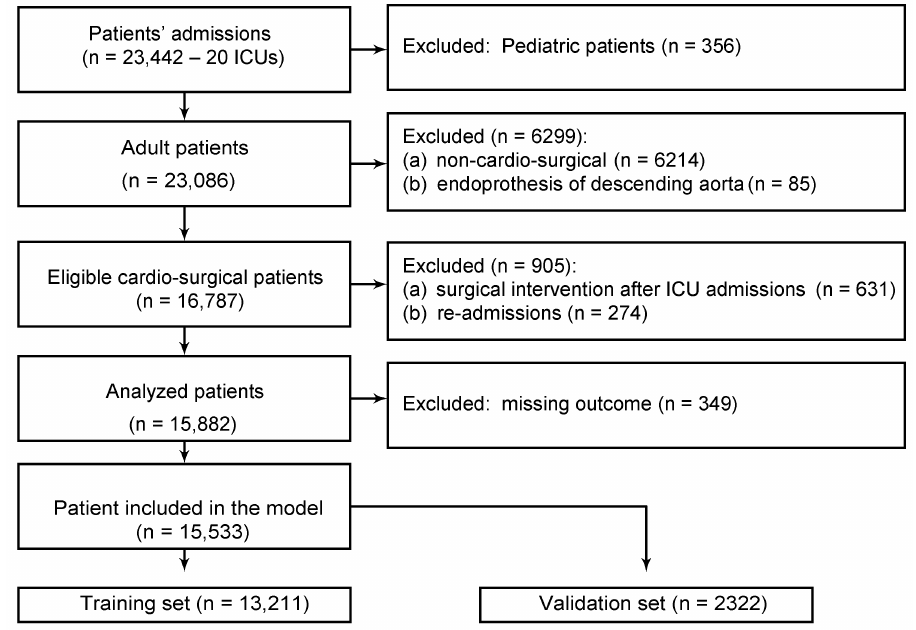
Figure 1. Study flowchart. Table 1. Patient description and comparison between alive and dead patients ( p -values were com- puted with Wilcoxon–Mann–Whitney test for the continuous variables and chi-squared test for the categorical